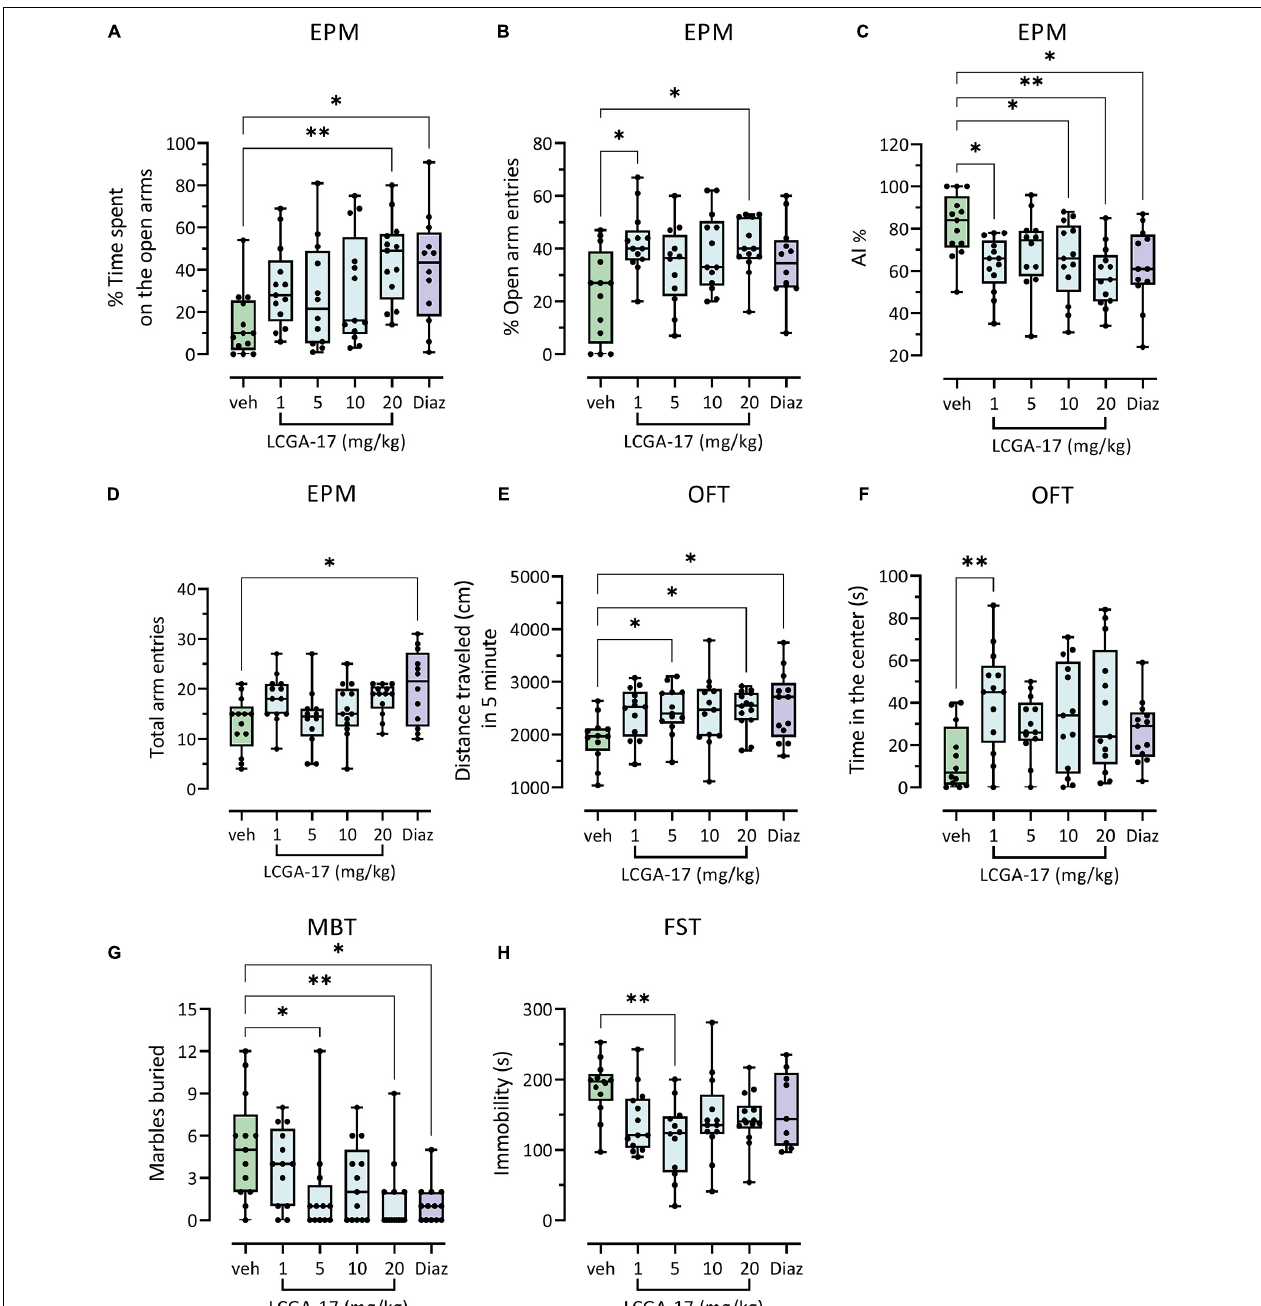
FIGURE 4 | Anxiolytic- and antidepressant-like efficacy of LCGA-17 in mice. Separate groups of mice ( n = 13) were injected with LCGA at the dosages indicated or diazepam (0.75 mg/kg) followed by behavioral analyses 30 min later, employing one test every 2–3 days. (A–D) In the EPM, LCGA-17 dose-dependently increased the percentage of time spent on open arms, with maximal effects at the highest dosage tested (20 mg/kg) [ H (5, 70) = 14.9; p = 0.01; Kruskal–Wallis, Dunn’s test] similar to diazepam (0.75 mg/kg) (A) . An anxiolytic-like effect of LCGA-17 was also observed based on percent open arm entries, which was significant at both 1 and 20 mg/kg [ H (5, 70) = 10.9; p = 0.05; Kruskal–Wallis, Dunn’s test] (B) and across the entire doses range when the two EPM parameters are combined into an Anxiety Index [ F (5, 70) = 3.4; p = 0.008; ANOVA, Dunnett’s test] (C) . LCGA-17 had no effect on total arm entries, in contrast to diazepam [ H (5, 70) = 12.2; p = 0.03; Kruskal–Wallis, Dunn’s test] (D) . (E,F) In the OFT, LCGA-17 (5, 30 mg/ml) and diazepam increased the distance traveled [ F (5, 70) = 2.3; p = 0.05; ANOVA, Dunnett’s test] (Å) . At a dose of 1 mg/kg LCGA-17 also increased time spent in the center of the arena [ Í (5, 70) = 11.0; p = 0.05; Kruskal–Wallis, Dunn’s test] (F) . (G) In the MBT, LCGA-17 (5, 20 mg/kg) reduced the number of marbles buried [ H (5, 70) = 18.0; p = 0.003; Kruskal–Wallis, Dunn’s test] similar to diazepam ( p < 0.05), indicating an anxiolytic response. (H) In the FST, the total time spent immobile was reduced at 5 mg/kg LCGA-17 [ F (5, 70) = 3.1; p = 0.02; ANOVA, Dunnett’s test] but at none of the other dosages, nor by diazepam. ∗ p < 0.05, ∗∗ p < 0.01 vs. vehicle.